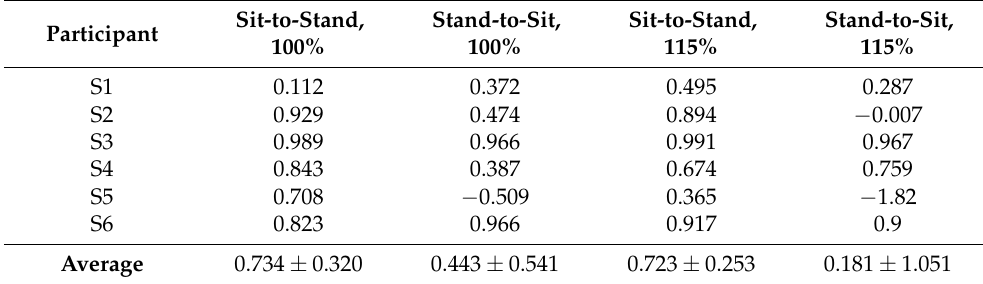
Table 4. R 2 values for different stroke participants for sit-to-stand and stand-to-sit actions at different seat heights, using k = 3 and height and weight as k − NN coordinates.